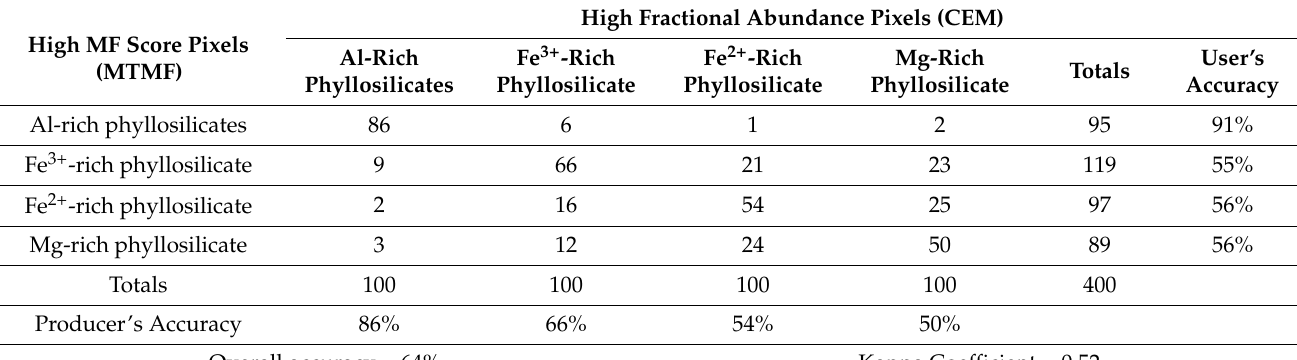
Table 4. Error matrix for the MF score images versus the CEM fraction images derived from TIR bands of